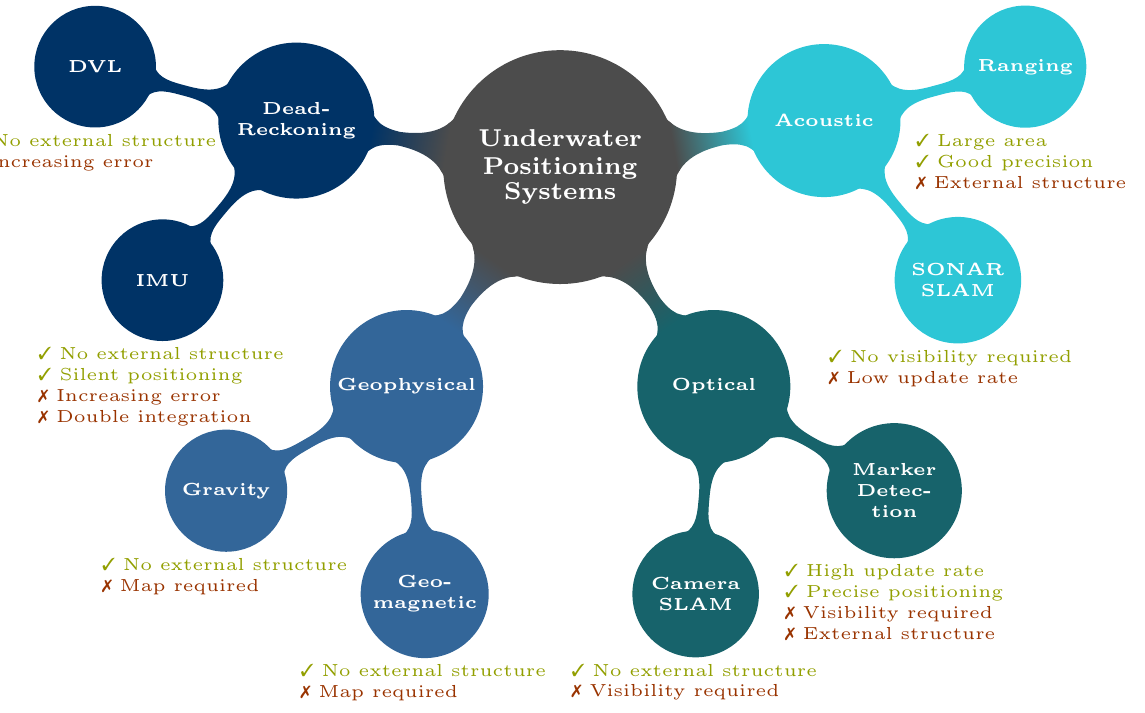
Figure 5. Comparison between different underwater positioning systems based on [22–24]. Abbre- viations: Doppler velocity log (DVL), inertial measurement unit (IMU), simultaneous location and mapping (SLAM), sound navigation and ranging